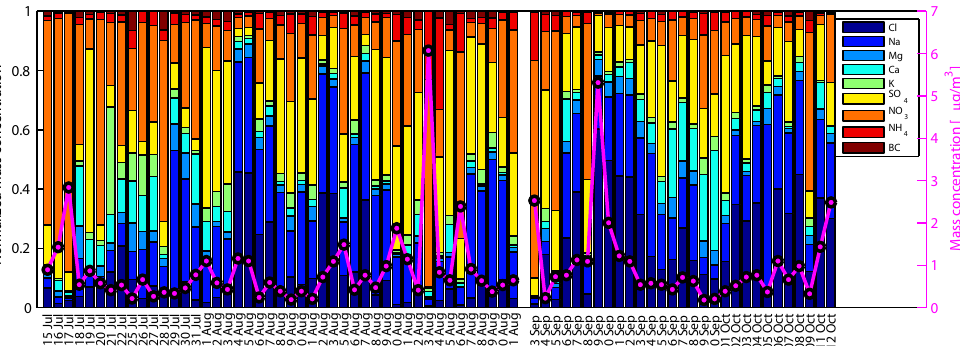
Fig. 4. Normalized filter measurements of aerosol components (colored bars) and the total mass (magenta line). Shown are only days, where all aerosol components were analyzed completely (exception: 26 and 27 July, where no BC measurements were available, but are assumed to be as low as on the other days). The measurements were performed without a specific size cut (open face